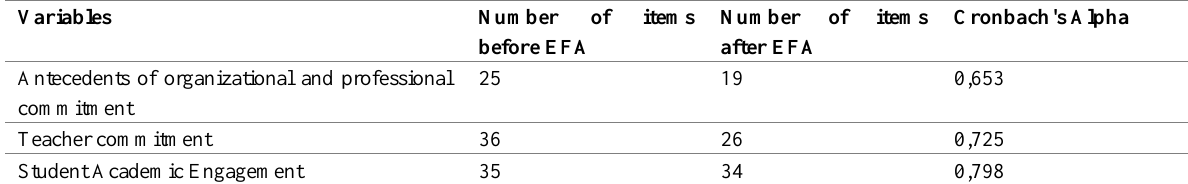
Table 4: Summary of the results of the principal component analysis